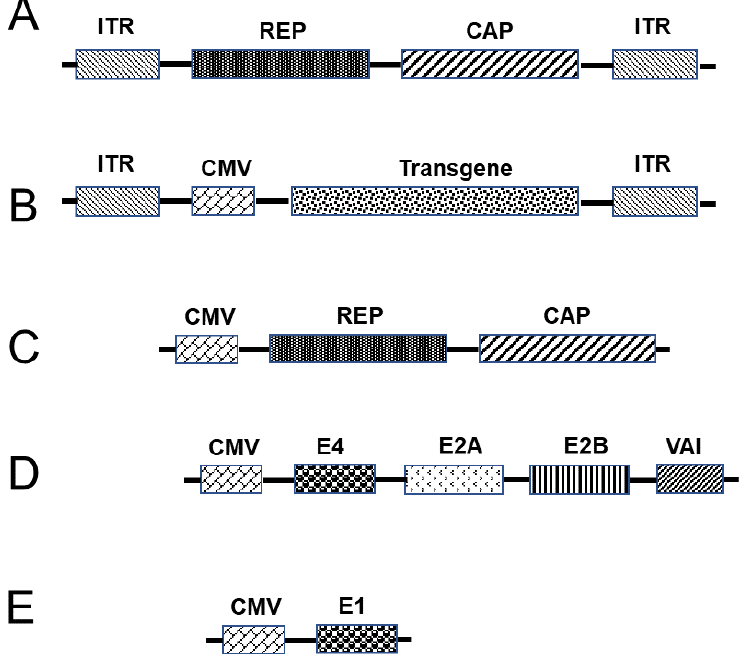
Figure 3. Adeno-associated-based vaccine. ( A ) The wild-type adeno-associated virus (AAV) ge- nome can be modified by replacing the gene for replication (REP) and structural genes (CAP) with the transgene of interest. ( B ) A transgene containing promoter and regulatory elements is cloned between the two inverted terminal repeats (ITRs) to generate a recombinant AAV (rAAV) genome. For the production of rAAV particles, the construct carrying the transgene should be co-trans- fected in permissive cells with plasmids that contain REP and CAP genes ( C ), and adenovirus helper genes ( D , E